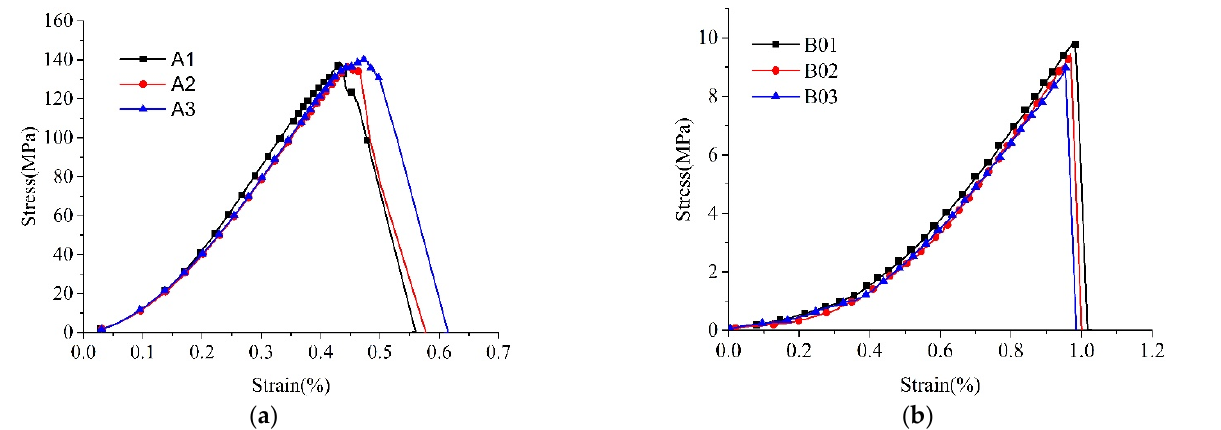
6 of 17 Figure 4. Brazilian splitting experimental device. ( a ) ( b ) Figure 5. Three-point bending experiment information. ( a ) Schematic diagram; ( b ) Specific device. The measured results from the three different kinds of experiments were given in Figures 6 and 7. From these figures, it can be seen that the experimental measured data have a good reproducibility and the results have a fine reliability. Then, through the pro- cessing of the experimental data, several macro-responses of granite can be obtained and the value of the variable is the average of the measured results. Hence, the basic mechan- ical property parameters of granite were listed in Table 1, which include Poisson’s ratio ν